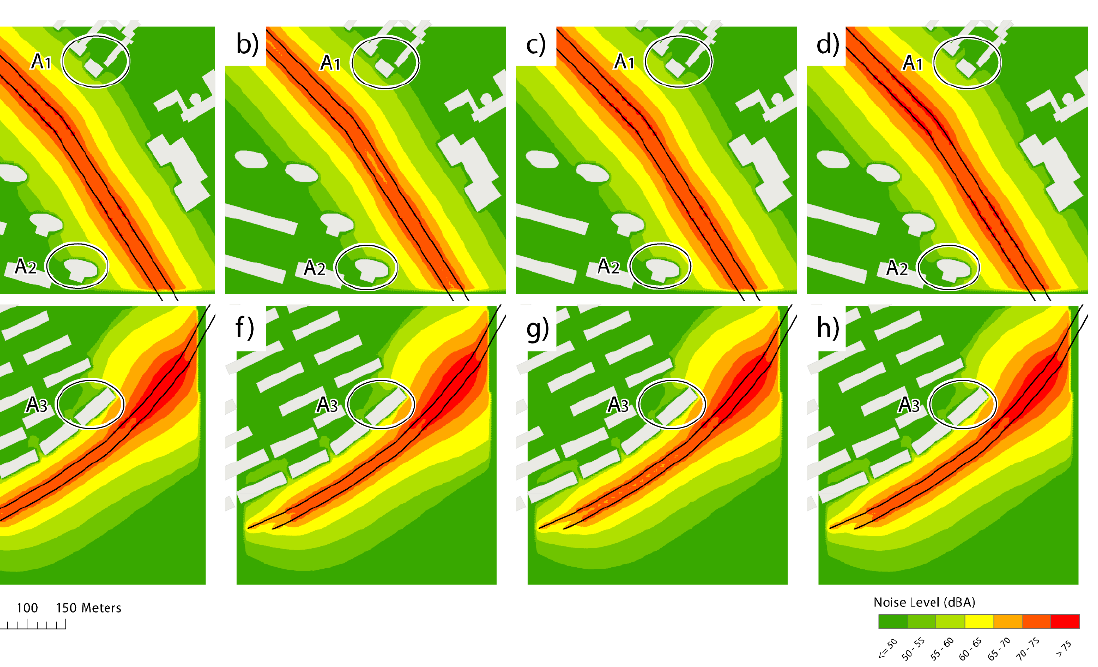
Figure 9. Dynamic traffic mapping in the experimental area. ( a – d ) are the noise maps of R1 and R2 at 15 min intervals. ( e – h ) are the noise maps of R3 at 15 min intervals.